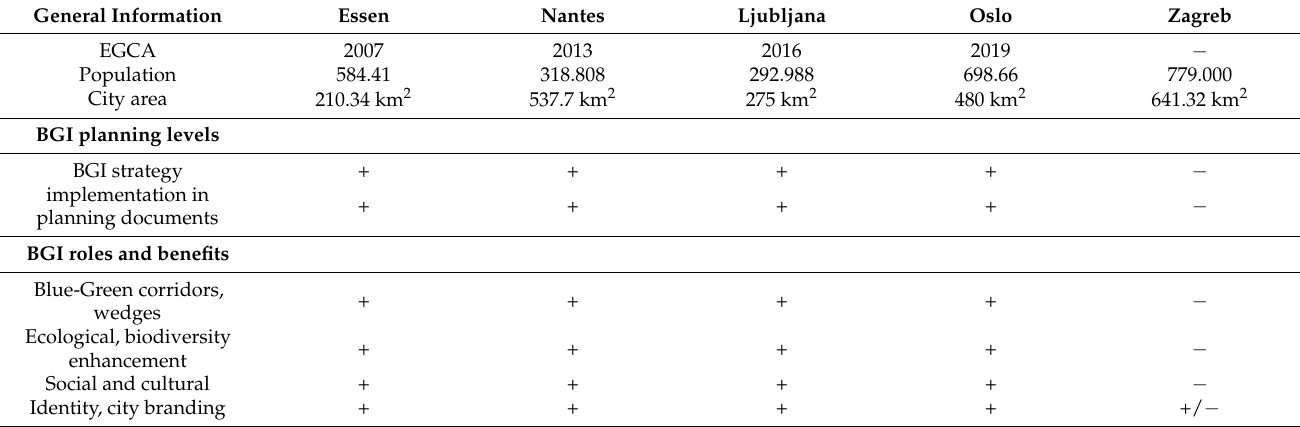
Table 2. Contemporary urban blue-green infrastructure (BGI) planning